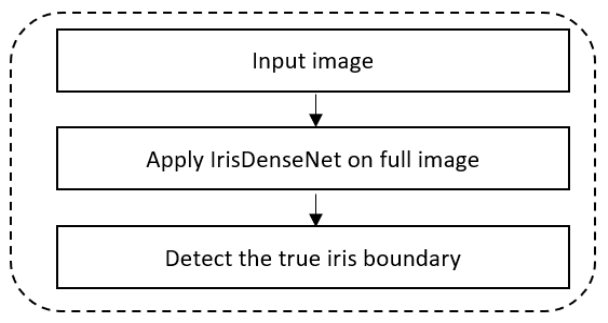
Figure 1. Flowchart of the proposed method.